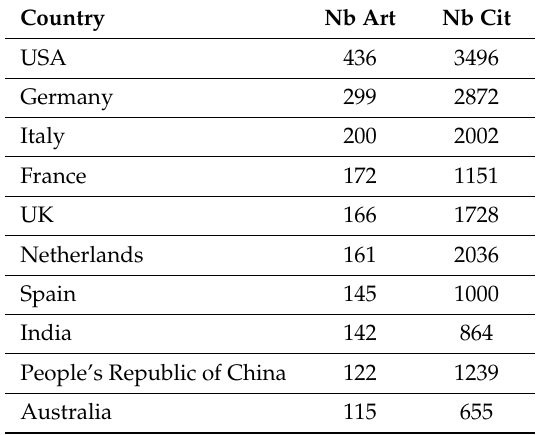
Table 8. The ten countries with the highest number of articles ( n = 2489).